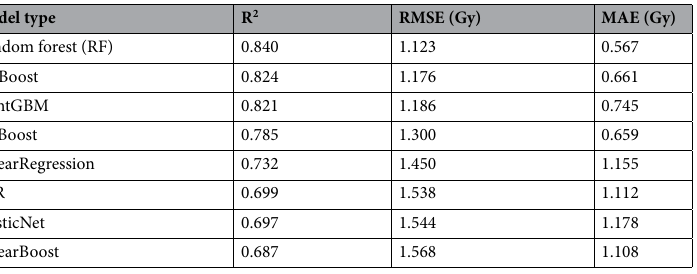
Table 2. Initial comparison of ML model performances for dose reconstruction. All models were trained on a randomly selected ¼ of the data set, and evaluated using R 2 , RMSE and MAE metrics on another ¼ of the data set. As described in the main text, the remaining ½ of the data was set aside for ultimate testing of the preferred